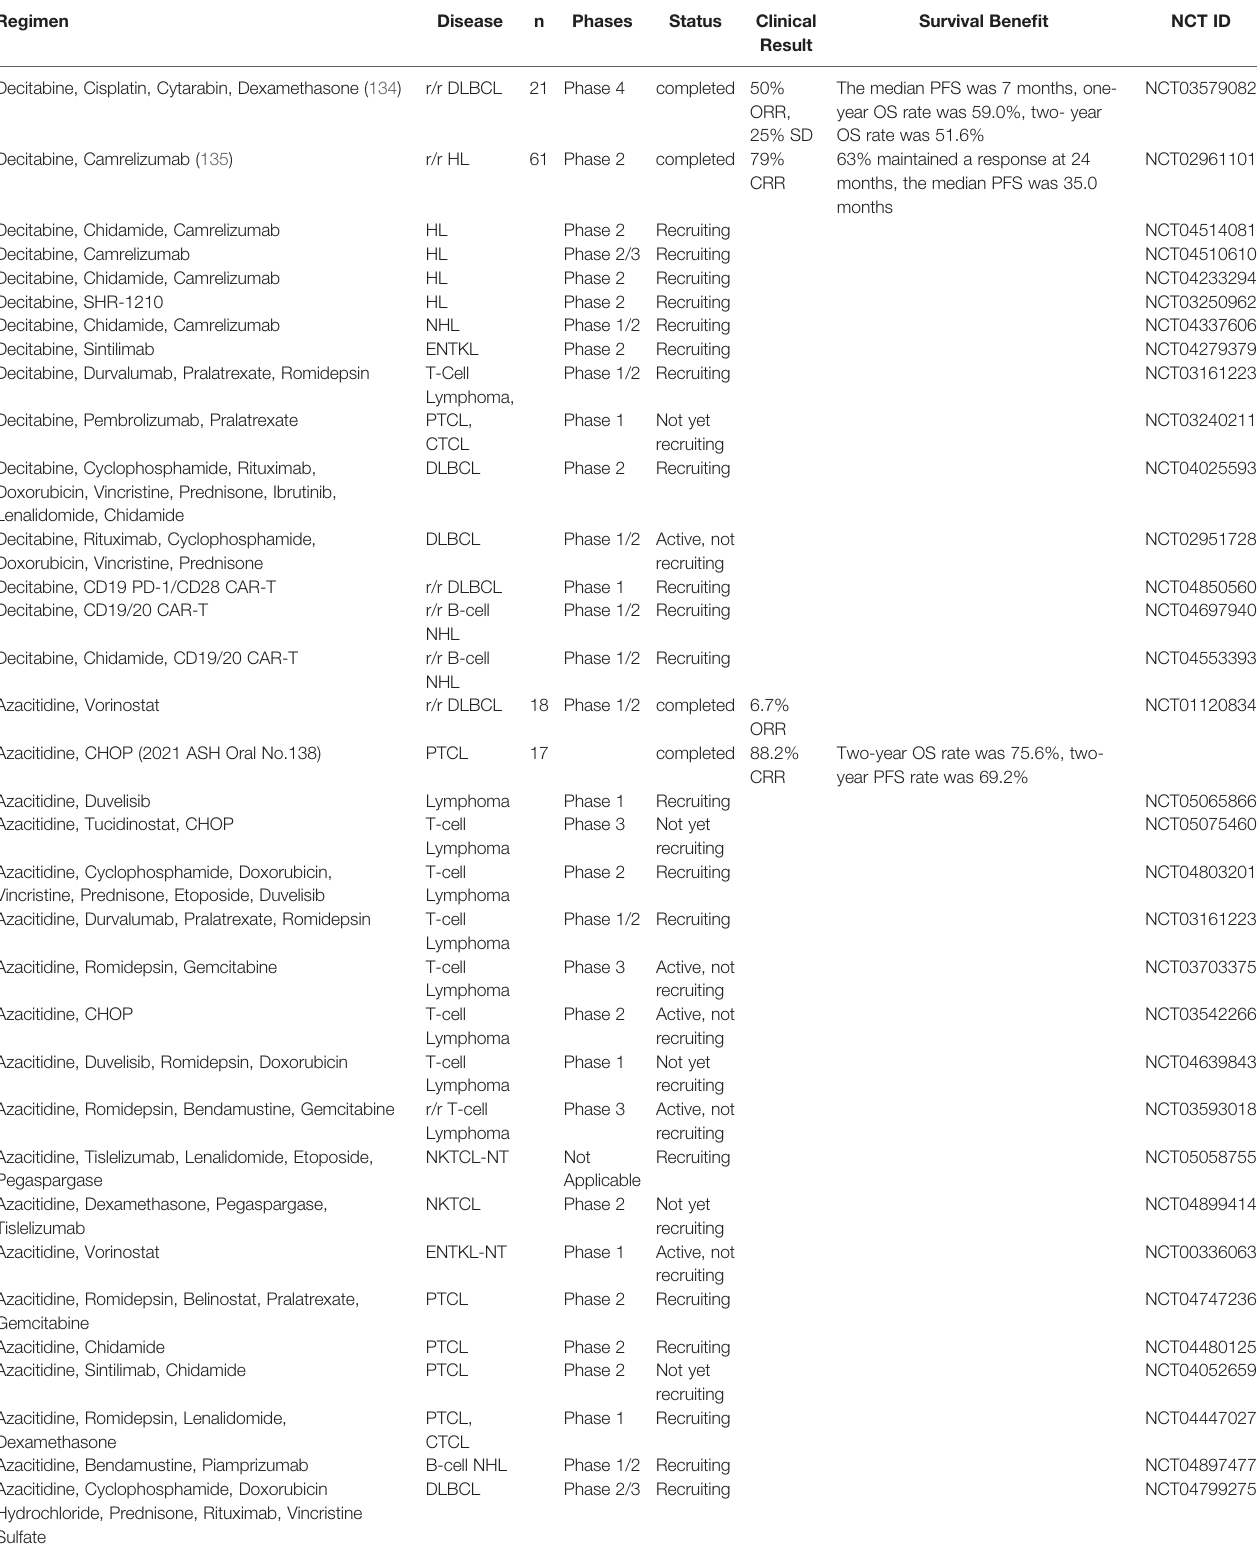
TABLE 1 | Clinical trials of DNA methyltransferase